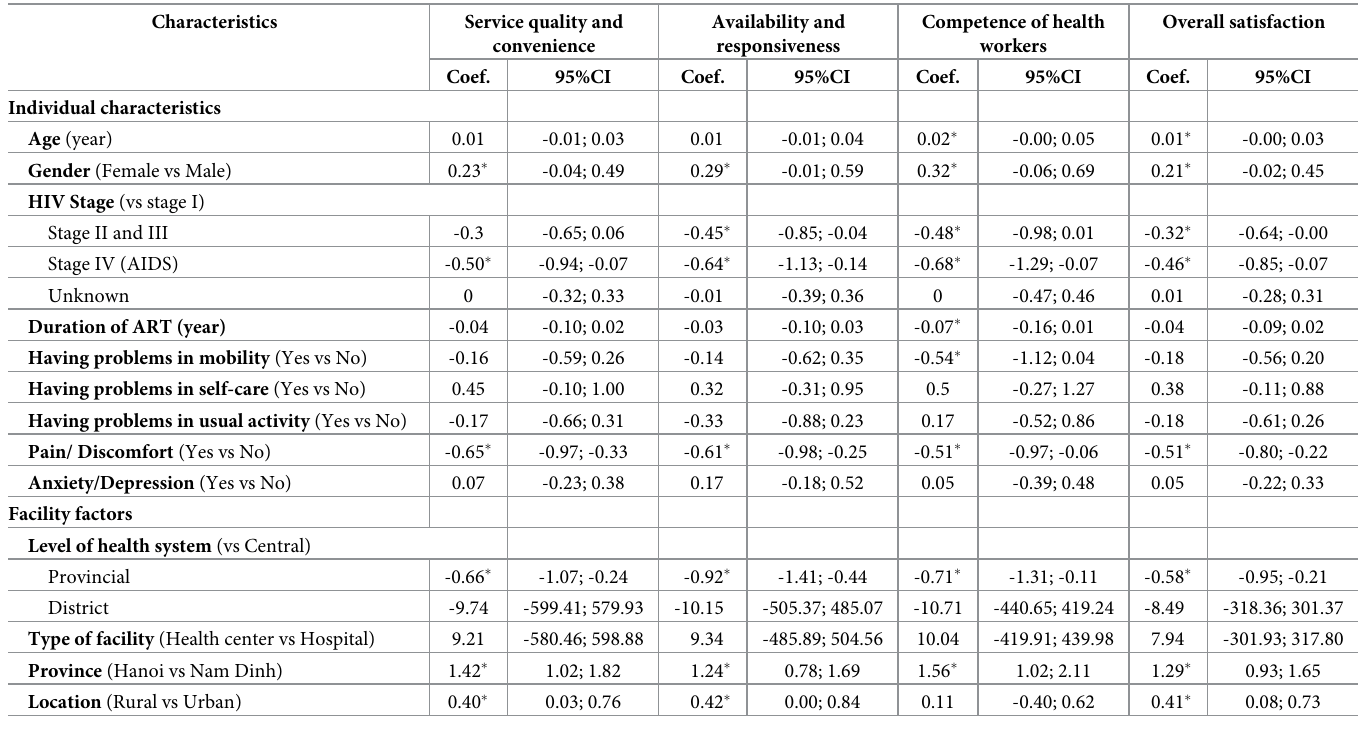
Table 4. Associated factors with the patient